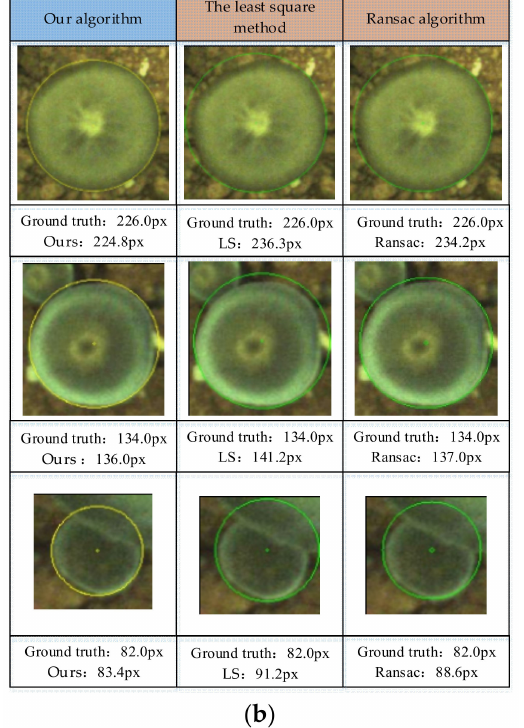
Figure 16. The fitting effect comparison between our, the least square and the Ransac